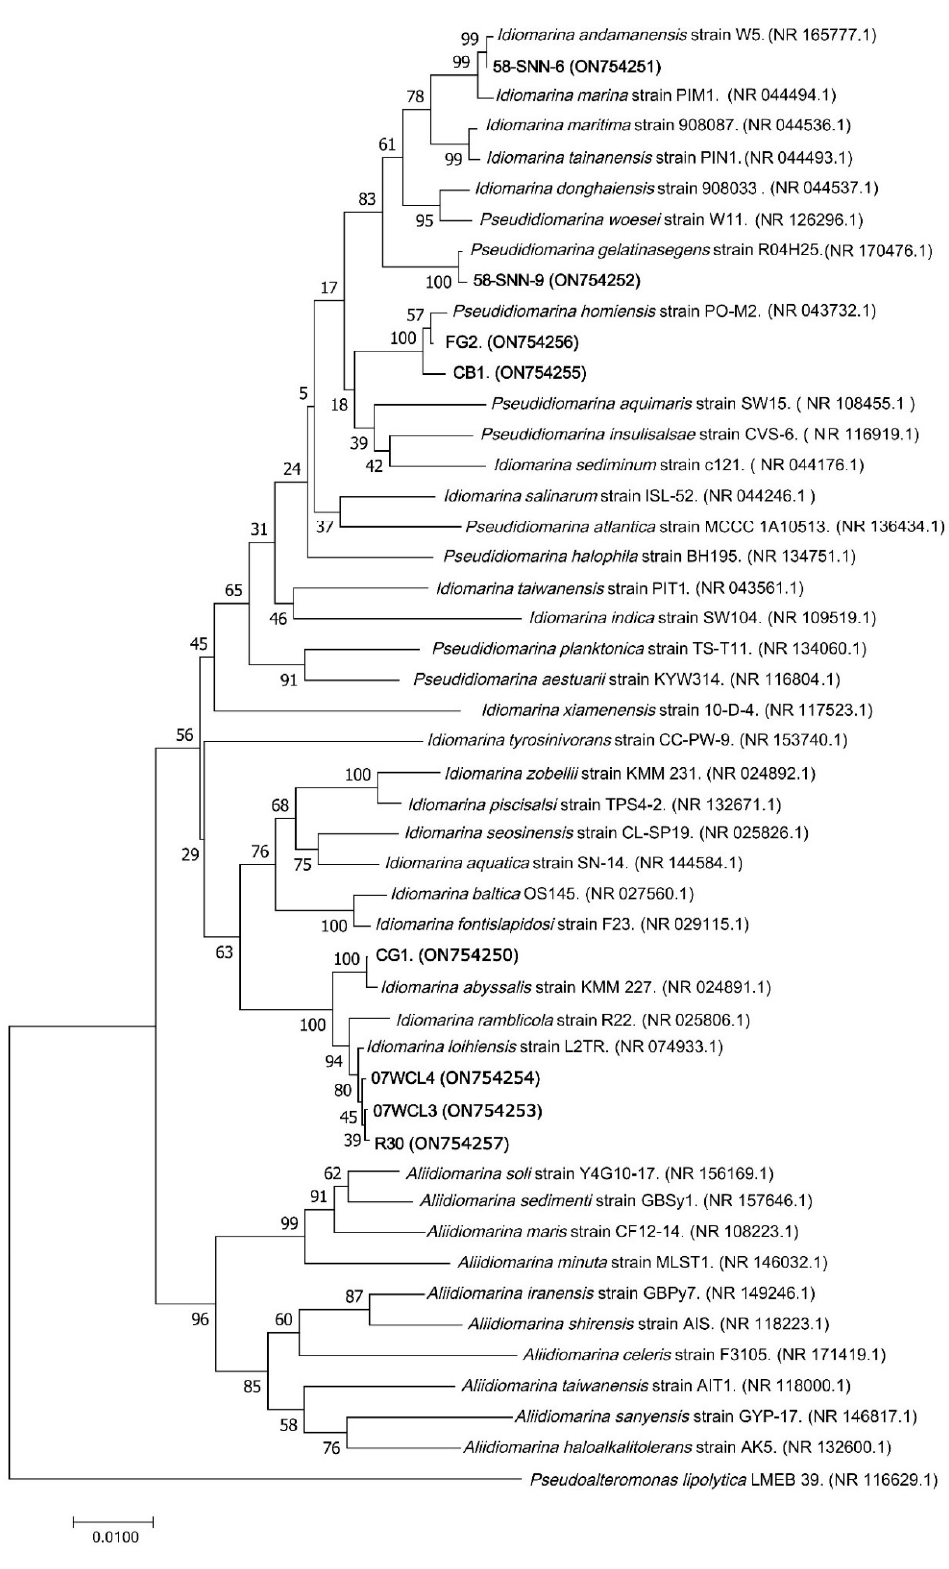
Figure 4. Unrooted phylogenetic tree reconstructed by the neighbor-joining method based on 16S rRNA gene sequences of strains CB1, FG2, CG1, 58-SNN-6, 58-SNN-9, 07WCL3, 07WCL4, R30, and other reference species in the family Idiomarina , demonstrating the phylogenetic relationship of the isolates. Bootstraps were calculated for 1000 replications and shown at branch nodes. Bar, 0.01 substitutions per nucleotide position. GenBank accession numbers are given in